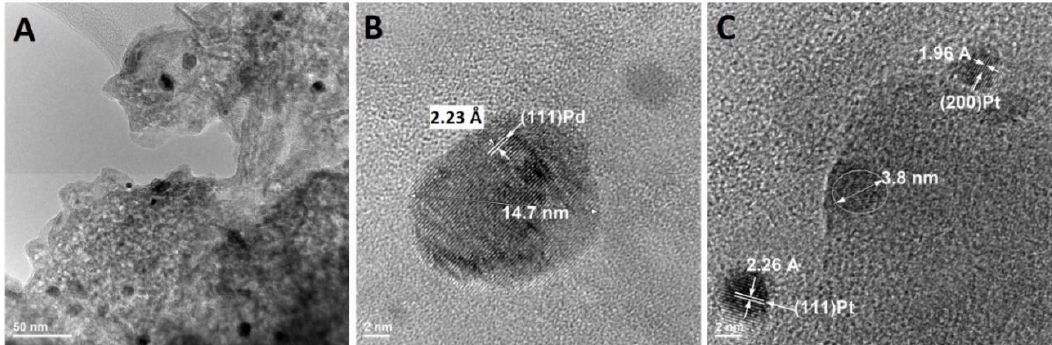
Figure 6. High resolution transmission electron micrographs of the spent automotive catalyst ( A ), Pd nanoparticles ( B ), and Pt nanoparticles ( C ) with their associated inter planar distance.